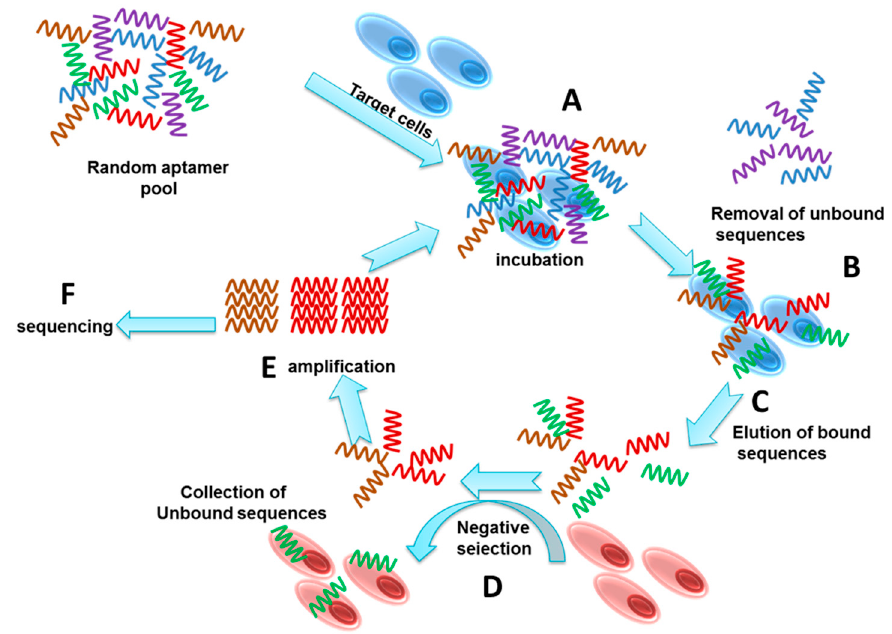
Figure 1. Schematic illustration showing the steps involved in Cell-SELEX. A . Incubation of cells with an aptamer library; B . Isolating bound sequences from unbound sequences; C . Elution of bound sequences; D . Negative selection to remove non-specific sequences; E . Amplification of target specific sequences; F . Sequencing of the selected aptamer pool.